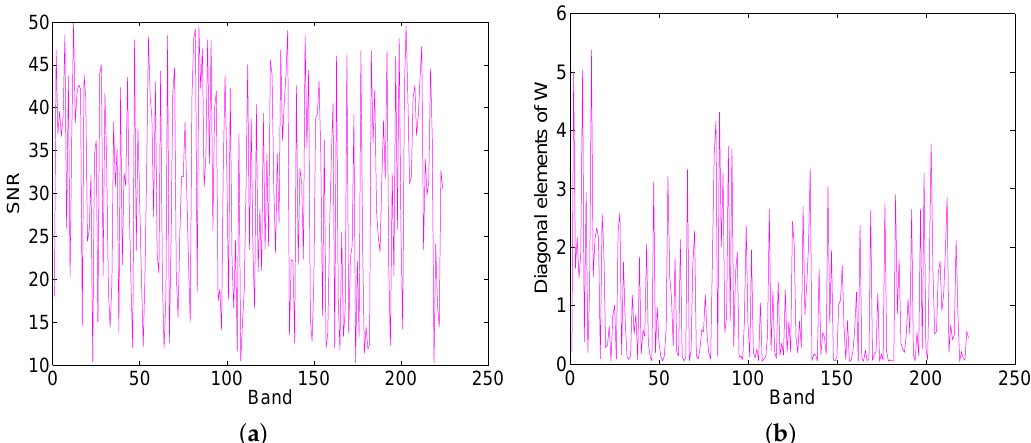
Figure 8. ( a ) The SNR of different band of the generated HSI and ( b ) diagonal elements of the weighting matrix using proposed SU-NLE in simulated experiment II.